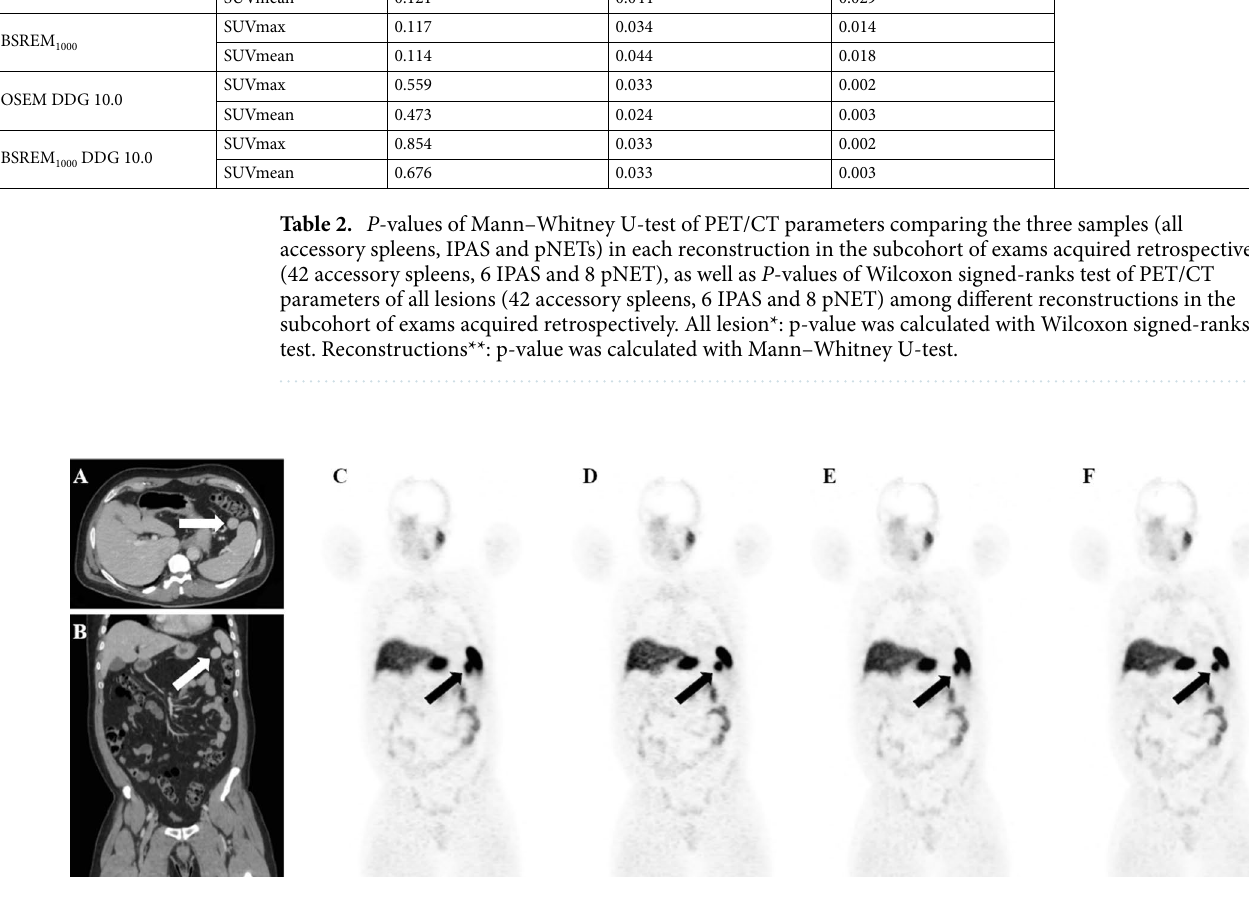
Figure 4. 68 Ga-DOTATATE PET/CT of a patient with an incidental accessory spleen, visible on contrast- enhanced CT images ( a , b ). The accessory spleen is better defined with DDG and yields higher SUVmax (30.8 on OSEM ( c ), 35.1 on OSEM-DDG ( d ), 32.4 on BSREM ( e ) 37.0 on BSREM-DDG ( f )) and lower PET volume (10,750 mm 3 on OSEM, 9320 mm 3 on OSEM-DDG, 10,150 mm 3 on BSREM 9130 mm 3 on BSREM-DDG). Furthermore, BSREM-DDG shows better noise characteristics compared to